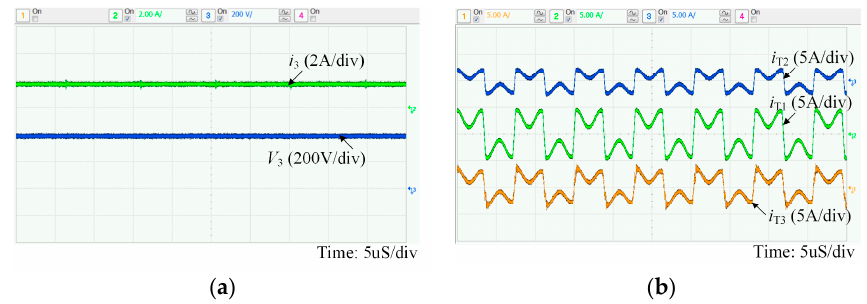
Figure 13. Experimental results of MR-TP-BDC under forward half load operating mode: ( a ) output voltage and current of port 3; ( b ) resonant currents of three ports.